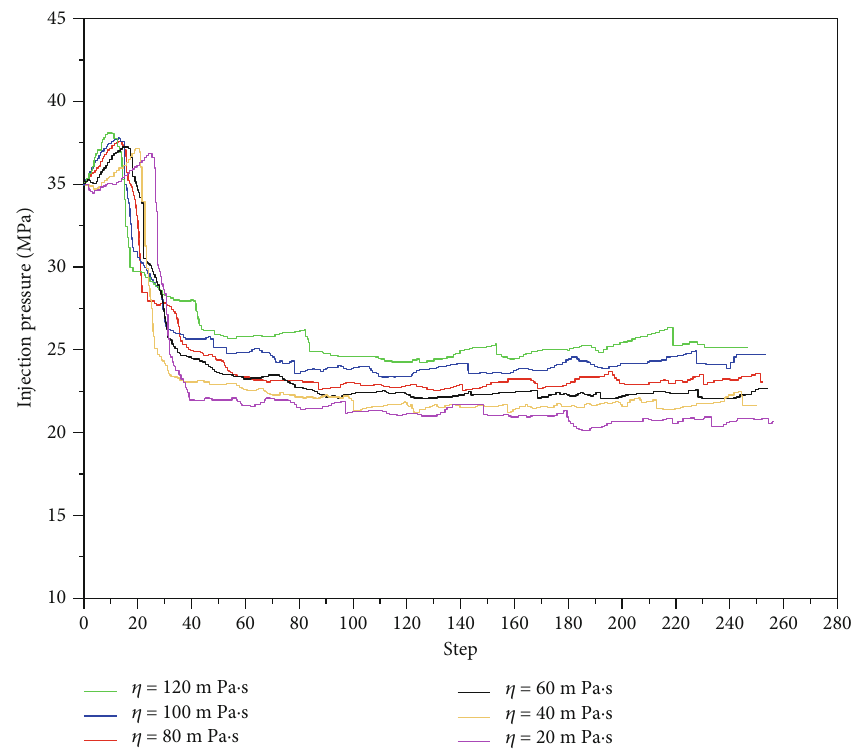
Figure 22: Injection pressure-step curves under di ff erent fracturing fl uid viscosity.